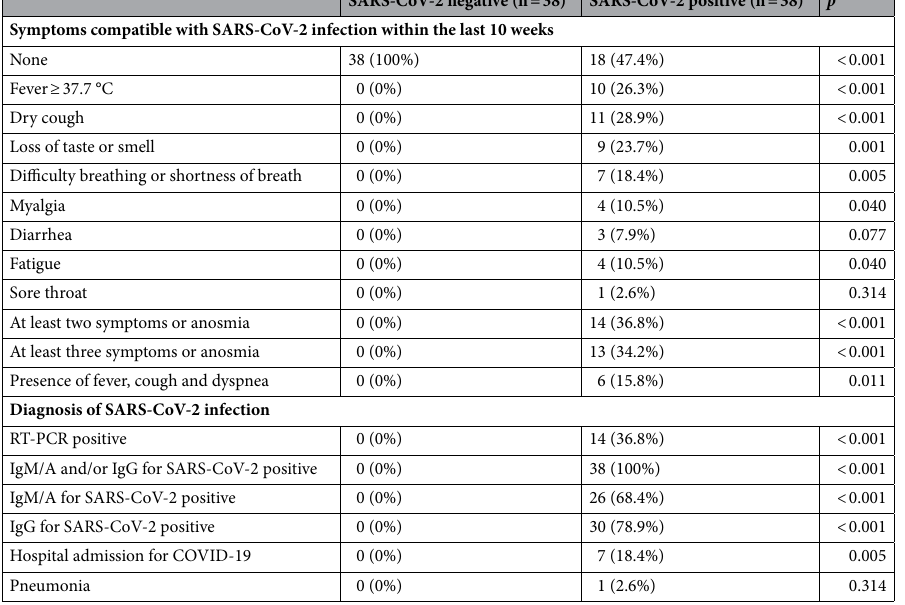
Table 2. Clinical characteristics of the study population subdivided according to SARS-CoV-2 infection. Data are n (%). SARS-CoV-2 severe acute respiratory syndrome coronavirus 2 (SARS-CoV-2), RT-PCR reverse transcriptase polymerase chain